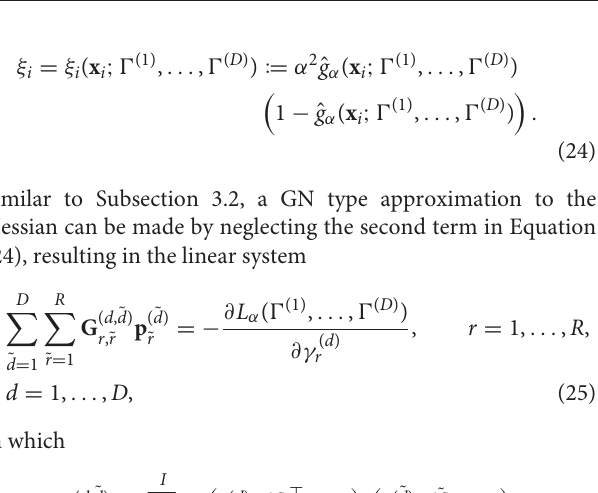
FIGURE 7 | The NASA dataset of the UCI machine learning repository is well modeled by a R test error. This indicates the benefits of using (Equation 8) over a direct tensor product expansion (Equation 5), where no low-rank structures are exploited. For generating the results, the knot distribution is kept uniform for all